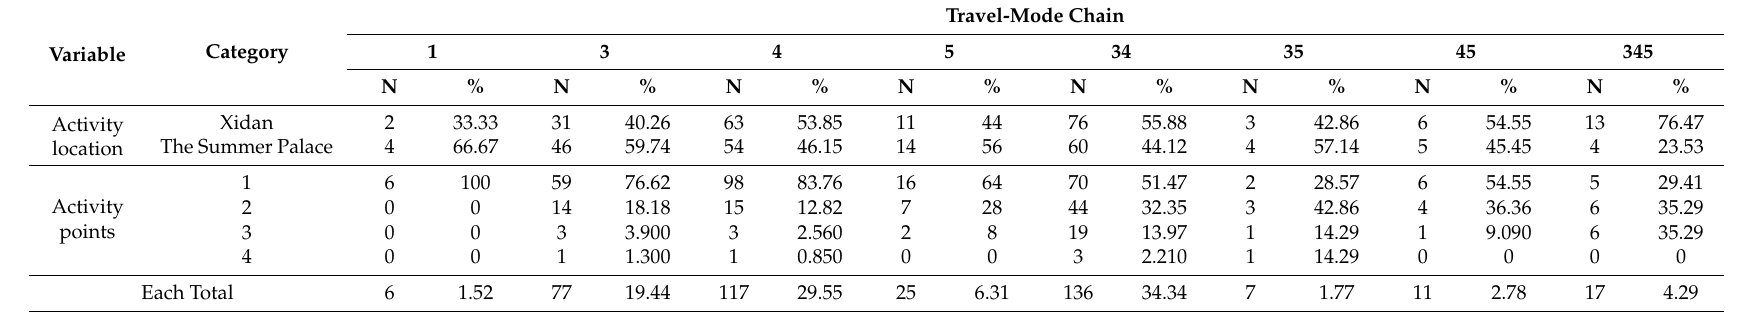
Table 6. Frequency distribution of activity characteristics over different travel-mode